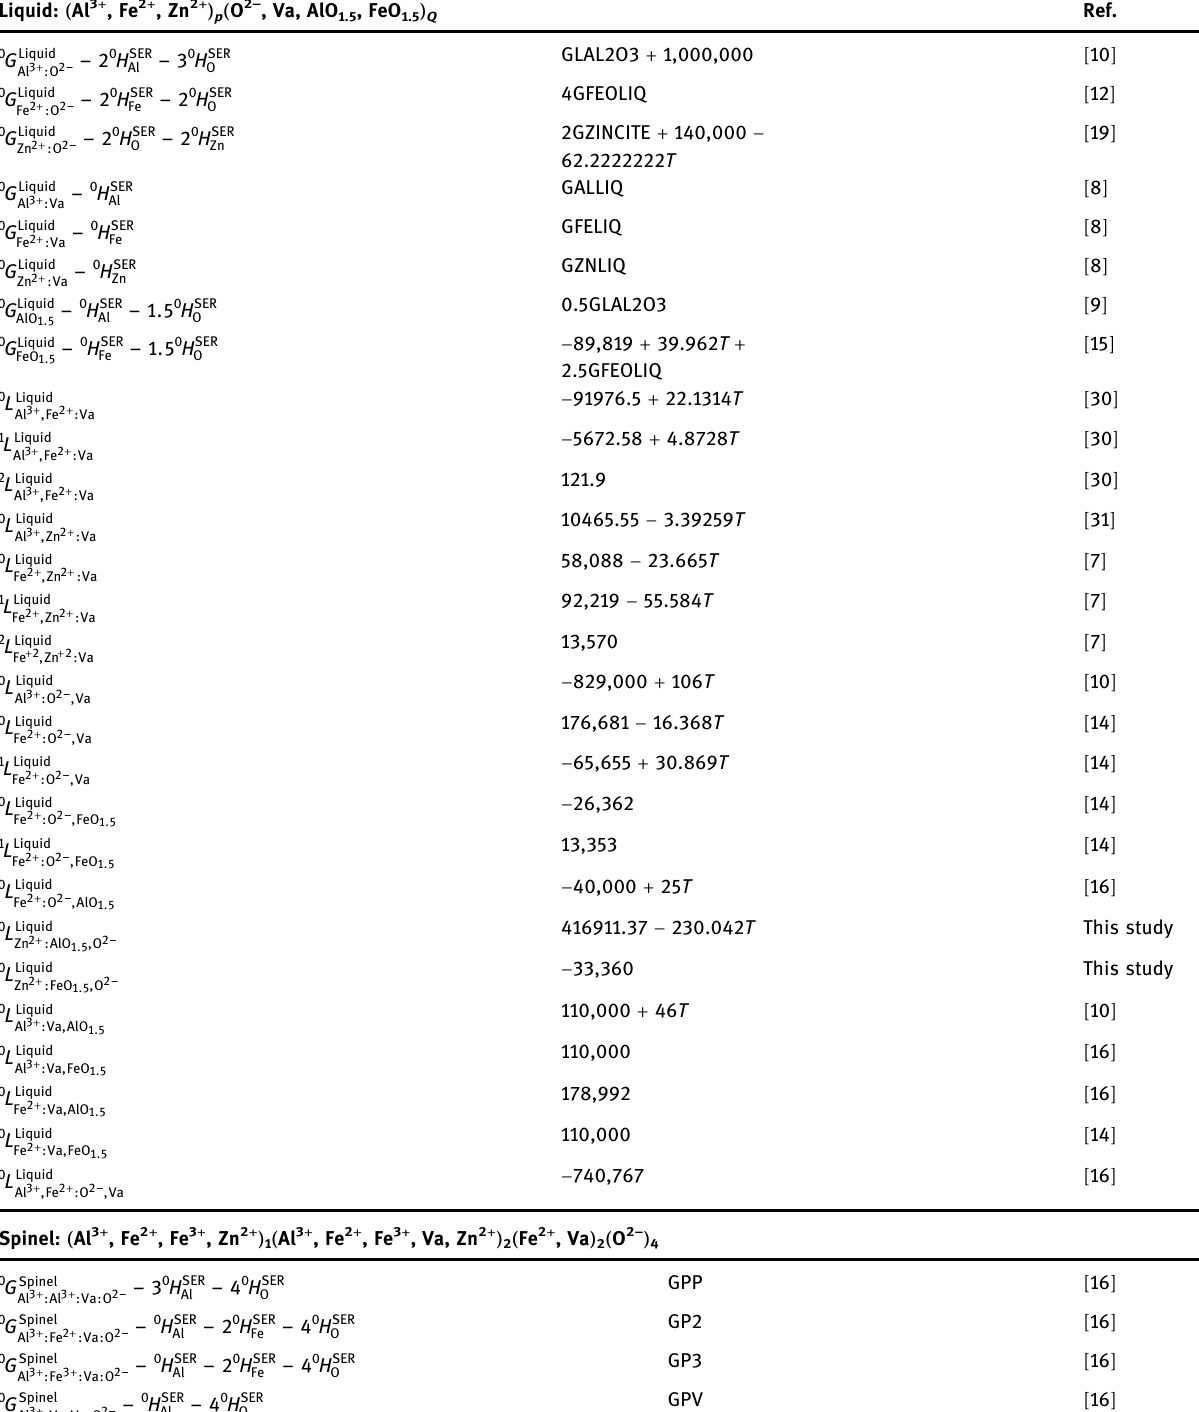
Table 1: Thermodynamic parameters for the Al – Fe – Zn – O quaternary system ( in units: J, mole, and K )